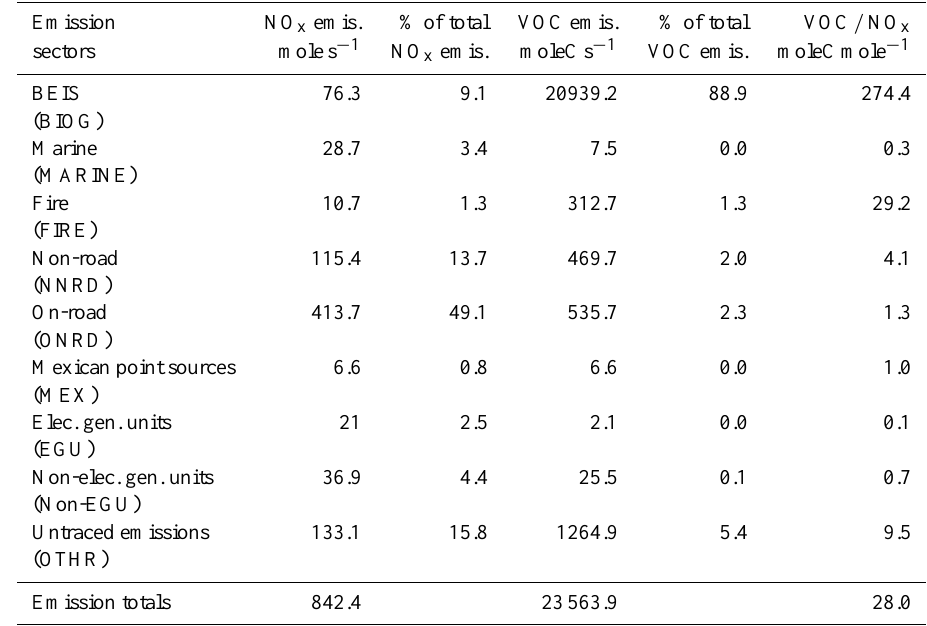
Table 2. All-hour domain averaged NO x and VOC emissions rates for Californian 12km domain during the period 28 June–5 July 2007. Emission NO x emis. % of total VOC emis. % of total VOC / NO x sectors moles − 1 NO x emis. moleCs − 1 VOC emis. moleCmole − 1 BEIS